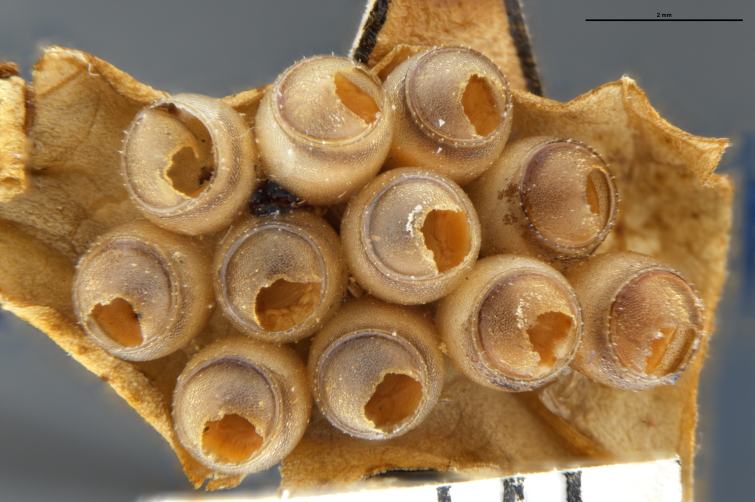
Host egg mass ofTrissolcus
mitsukurii (ZJU 816020-1)